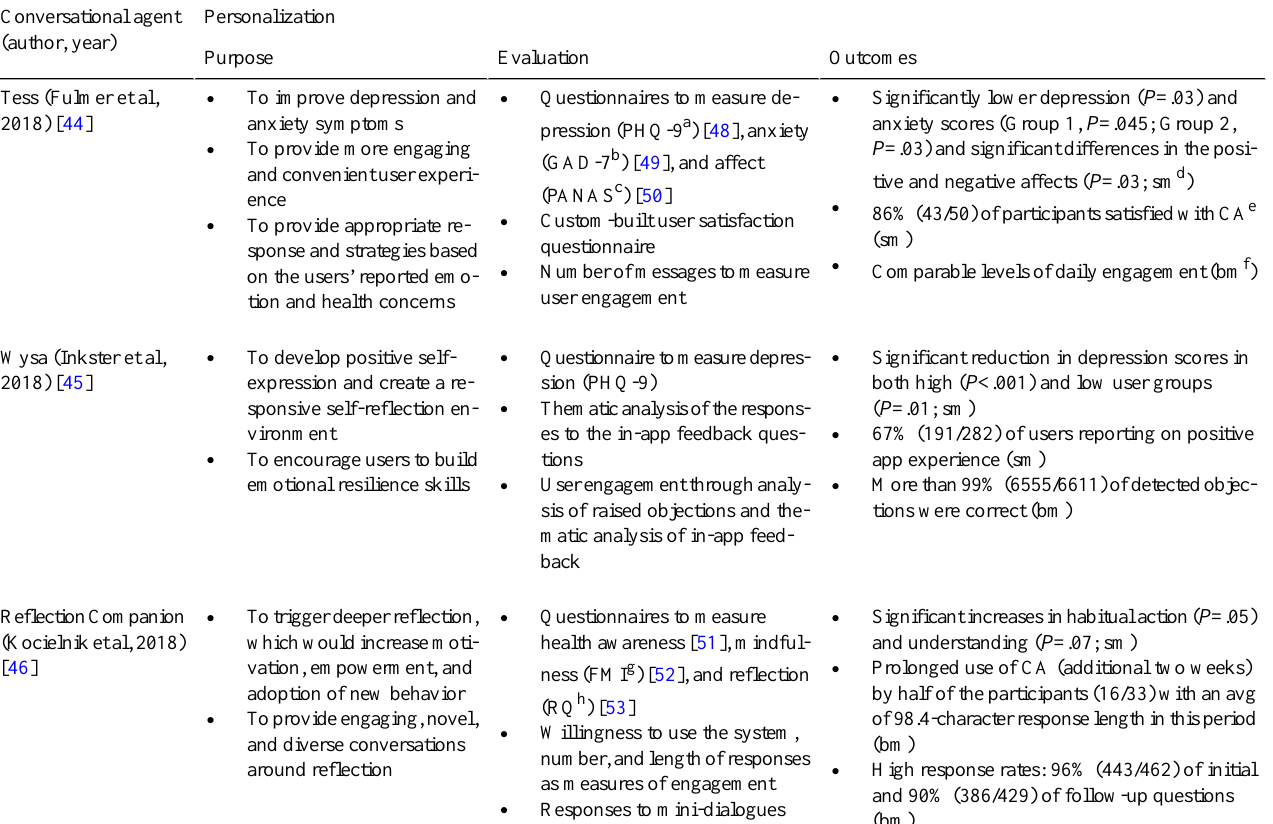
Table 3. Personalization purpose, evaluation, and outcomes in the included